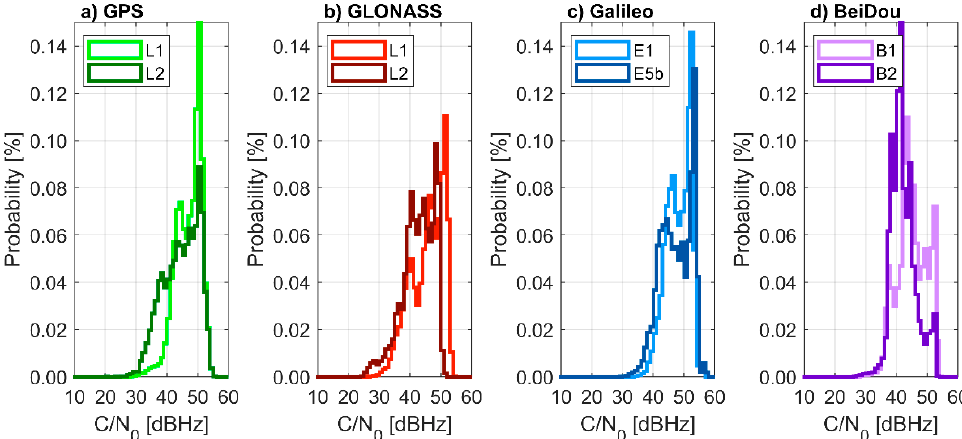
Figure 4. Histograms of carrier-to-noise ratio (C/N 0 ) for each Global Navigation Satellite Systems ( a ) GPS, ( b ) GLONASS, ( c ) Galileo and ( d ) BeiDou and frequency, computed by using a u-blox receiver.